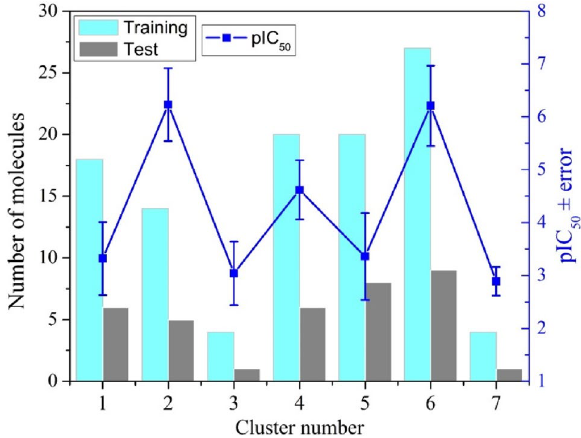
Figure 2. Training and test set splitting employing the K-means technique (25% test and 75% training).